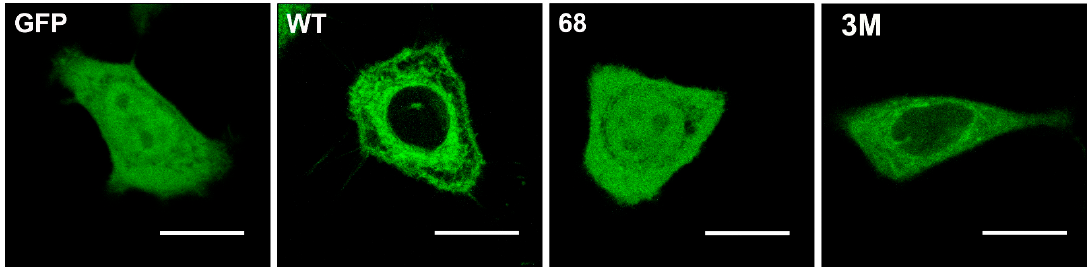
2222222221 Figure 2. G γ 2 protein–membrane interactions. The green fluorescent protein (GFP), containing the wild-type C-terminal region of the G γ 2 protein (WT), shows a membrane localization that does not coincide with that of GFP alone (GFP). Mutations that alter the presence of the isoprenyl moiety (68: C68S) or the 3 C-terminal basic amino acids (3M: R62G, K64G, K65G) have a huge impact on the distribution of the protein in SF-767 cells. Bar = 15 µ m (adapted from Reference